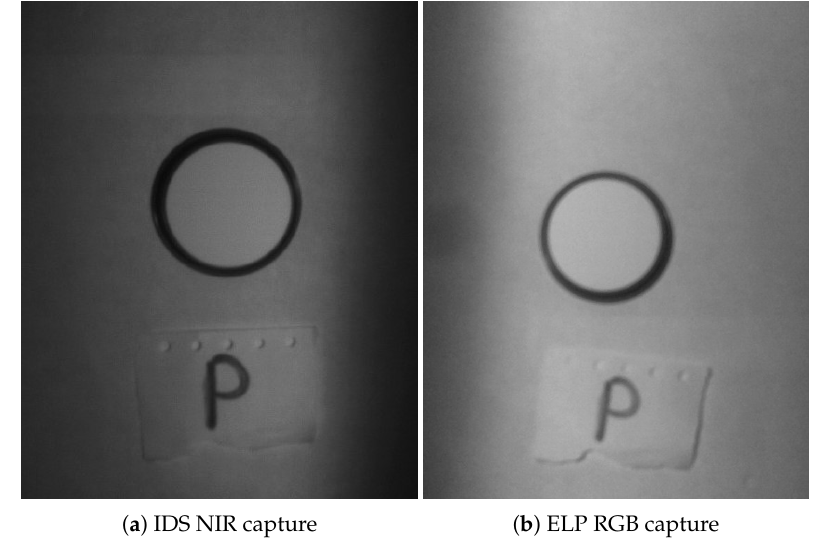
Figure 10. Golden reference polymer captures.